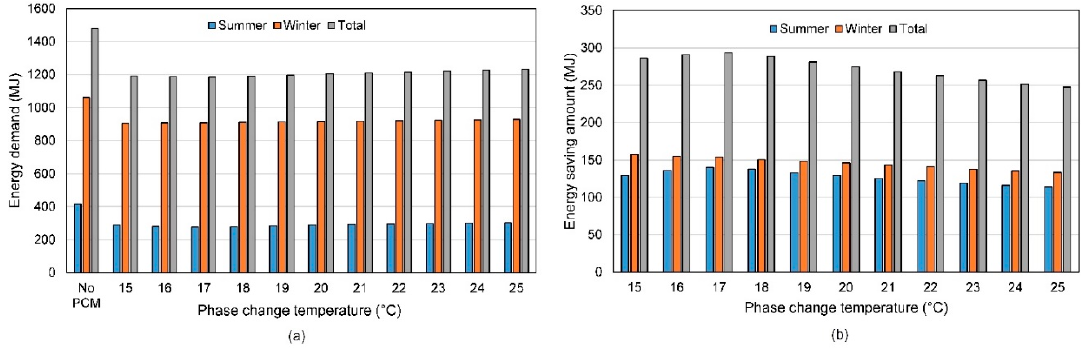
Figure 11. The influence of PCM phase change temperature on building energy for severe